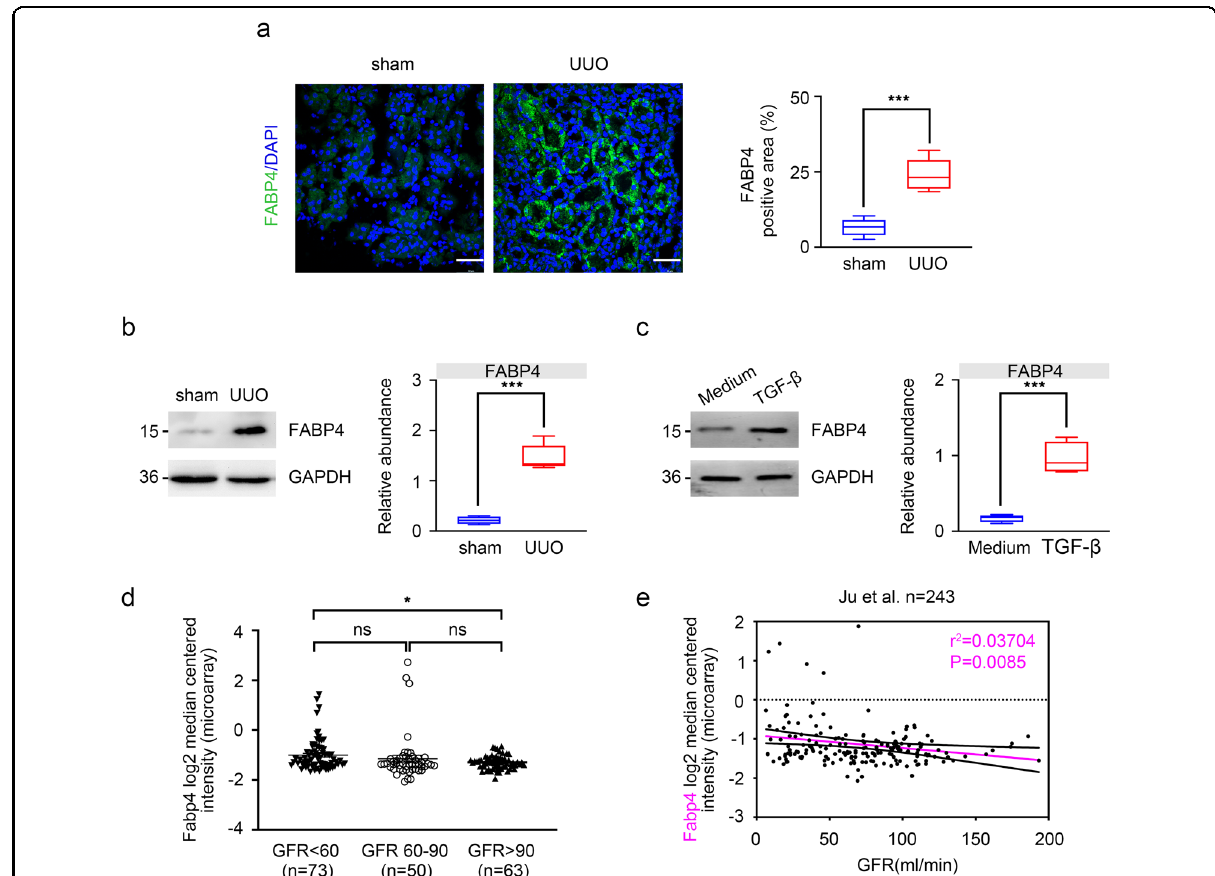
Fig. 1 Expression of FABP4 in UUO mice and TGF- β -treated HK-2 cells. a Fluorescence microscopy revealed that FABP4 was mainly expressed in kidney tubular epithelial, and increased in UUO-treated mice. Quantitative image to depict fl uorescence intensity (Right panel). Scale bars: 50 μ m. b Western blot showed that FABP4 was increased in UUO mice. Schematic representation of quantitative data of indicated proteins. Representative images from three independent experiments are shown above. n = 6 mice. c Protein expression of FABP4 was detected in HK-2 cells treated with 10 ng/mL TGF- β for 48 h. Schematic representation of quantitative data of indicated proteins. Representative images from three independent experiments are shown above. d In the study of Ju CKD tubules, CKD was associated with signi fi cantly increased mRNA value of Fabp4 compared with biopsy samples from health control. e A negative correlation between tubular FABP4 and eGFR was observed in public Ju CKD dataset. Data were presented as mean ± SEM. * P < 0.05, ** P < 0.01, *** P <0.001, ns means no statistical signi fi